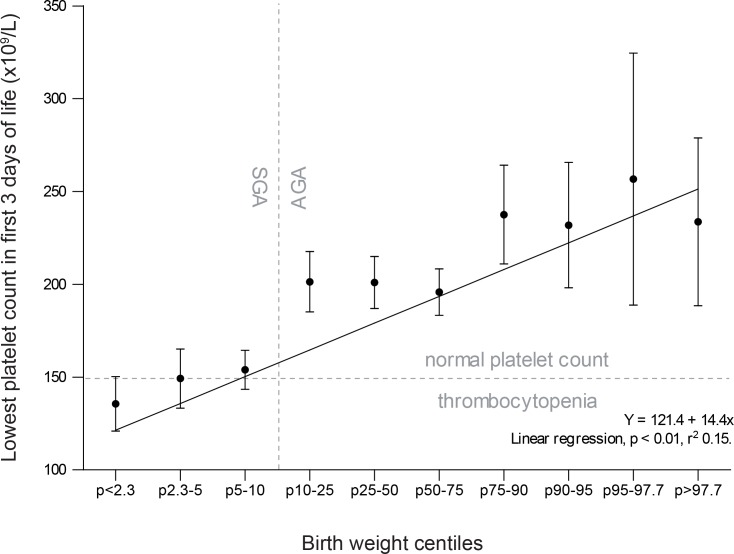
Relationship between lowest platelet counts in the first 3 days of life and birth weight centiles.Boxplot representing observed lowest platelet counts (x109/L) in all included neonates (SGA and AGA, N = 659) in the first 3 days of life, categorized by birth weight centiles. Boxplot shows mean (black dots) and 95% confidence intervals (whiskers), with a regression line.